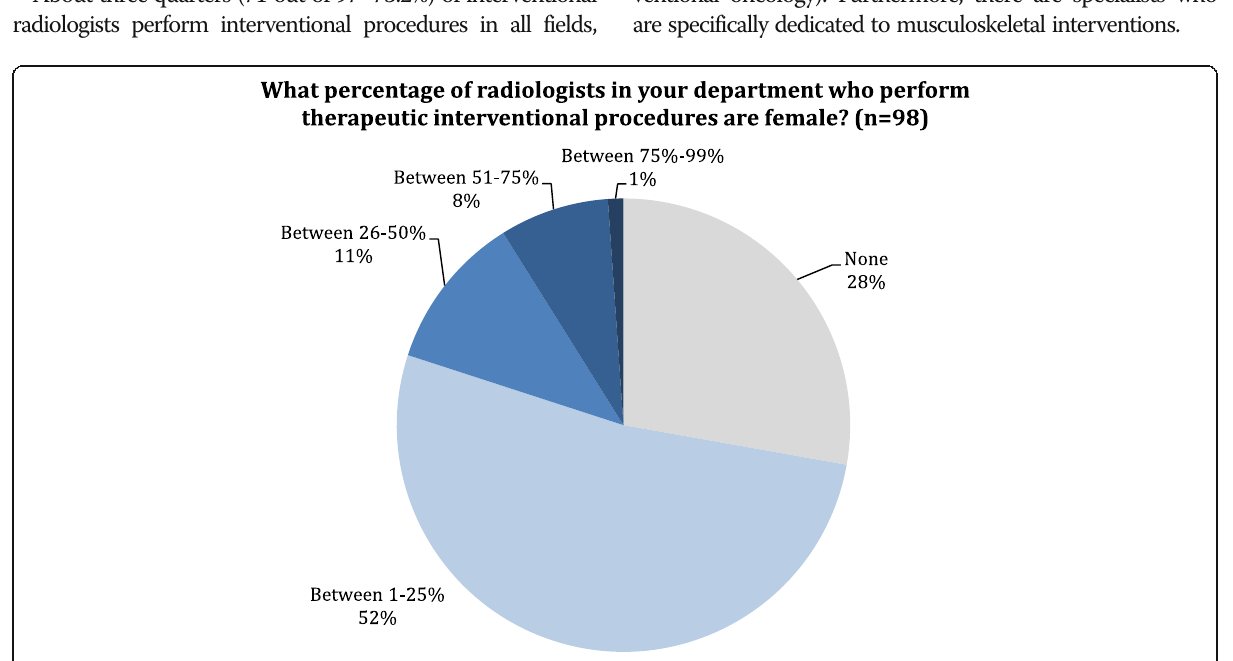
Fig. 2 Distribution of the answers to question 16: What percentage of radiologists in your department who perform therapeutic interventional procedures are